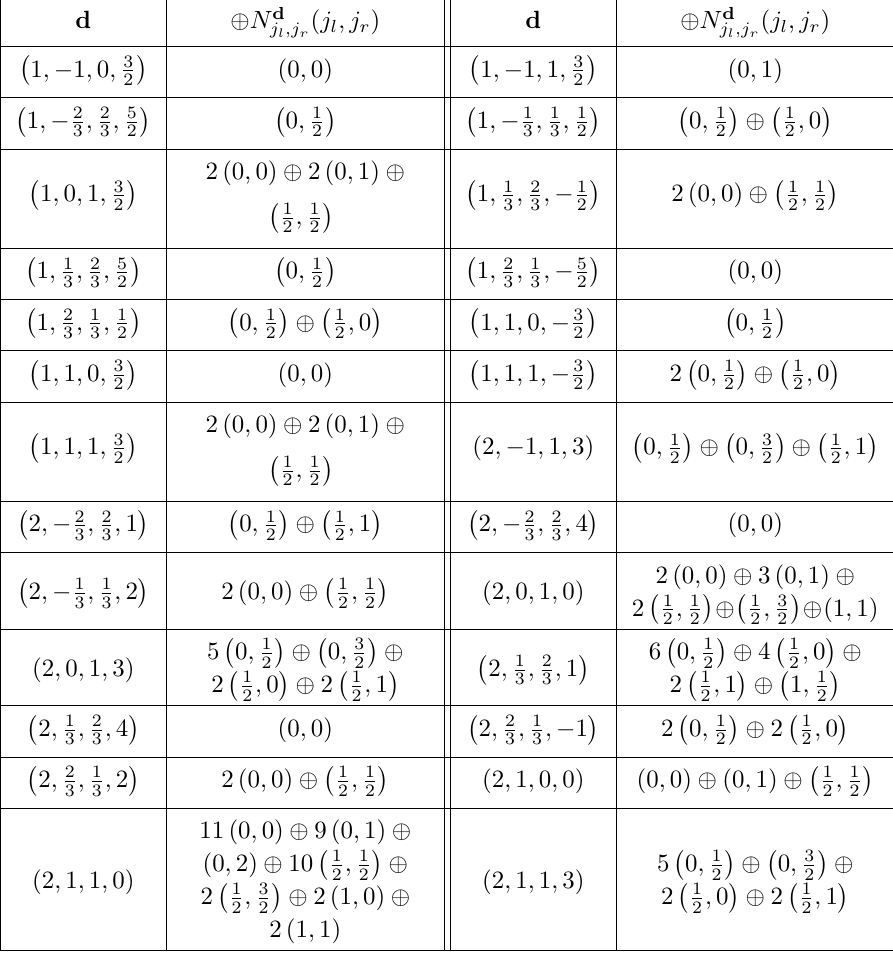
Table 22. BPS spectrum of the SU(3) + 1 Sym for d 1 ≤ 2 and d 2 , d 3 ≤ 1 . Here, d = 3 / 2 ( d 1 , d 2 , d 3 , d 4 ) labels the BPS states with charge d 1 m 0 + d 2 α 1 + d 3 α 2 + d 4 m 1 for simple roots α 1 and α 2 of su (3)